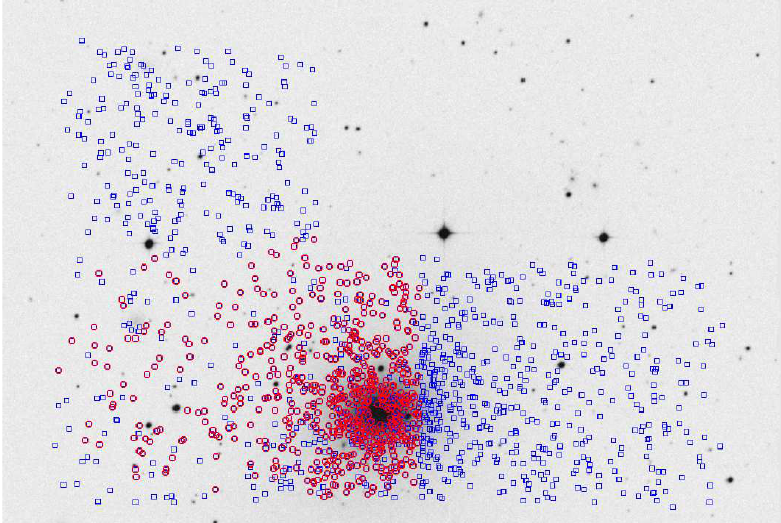
Figure 1. DSS red image of NGC1395 showing the optical globular cluster (GC) candidates (blue squares). The GC candidates detected in the NIR images ( ∼ 650) are shown in red. The size of this image is 12 × 17 arcmin. North is up and east is to the